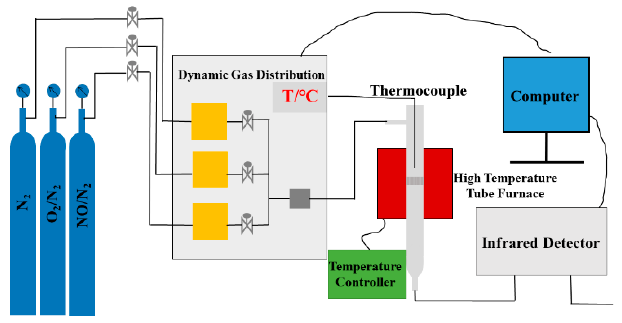
Figure 1. Diagram of the denitration system.